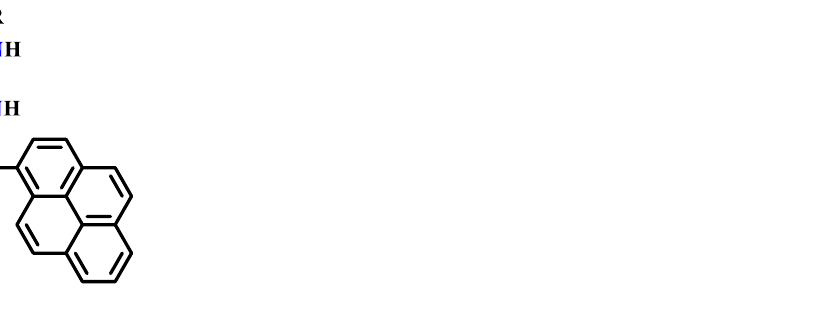
Figure 53. Pd(II) complexes of pyrene hydrazone with ( N -ethyl/cyclohexyl)-substituted thiourea as a side chain.